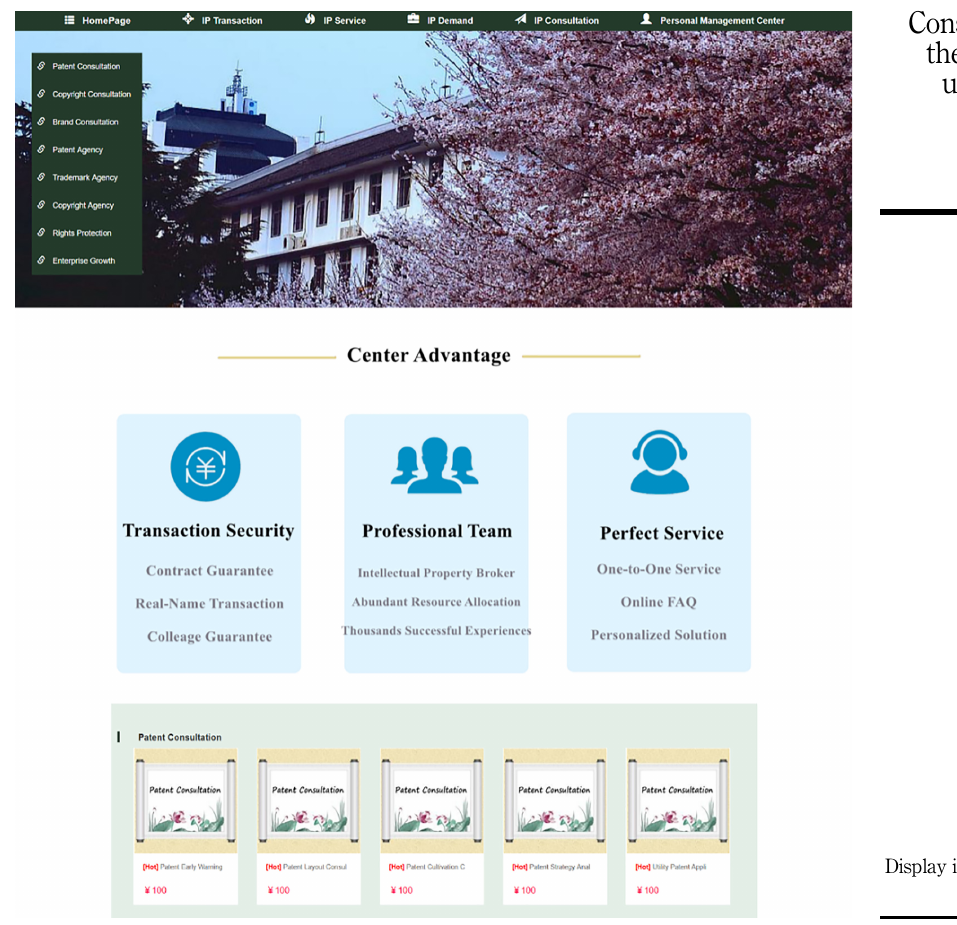
Figure 7. Display interface of IP